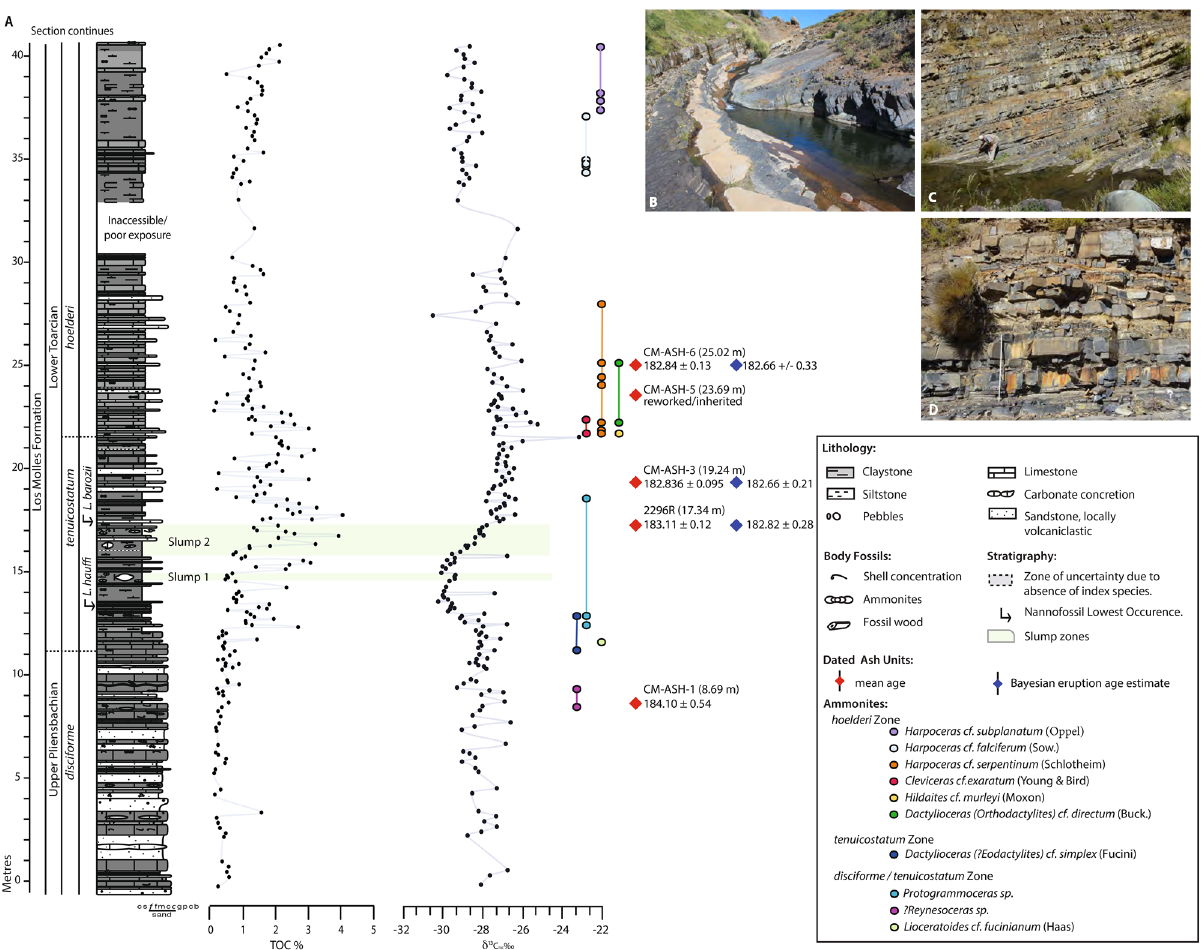
Figure 2. ( A ) Carbon-isotope chemostratigraphy including main formation names, lithology, total organic carbon (TOC) content, ammonite zones and occurrences, nannofossil biostratigraphy and radiometric ages for the Pliensbachian–Toarcian transition in the Chacay Melehue stream section. Photographs of Chacay Melehue Section: ( B ) light-coloured tuffaceous units interbedded in dark grey lithified units (~ 3 m in section), ( C ) unit with nodular base, thin tuffaceous units and well-indurated dark grey mudstones (~ 14 m to 18 m in section), and ( D ) sediments typical for the upper part of the section, with thin interbedded tuffaceous units (> 20 m in the